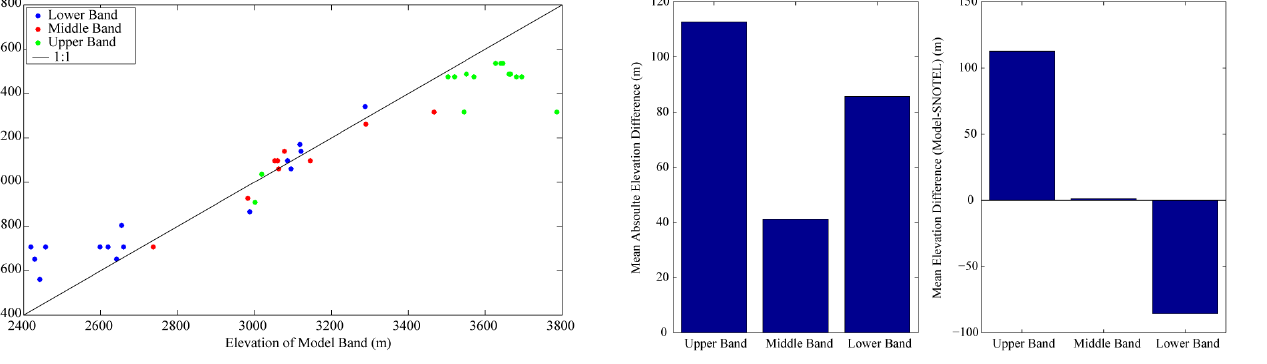
Fig. 3. Mean absolute difference (left) and mean difference (right) between model elevation and its respective SNOTEL elevation. A positive mean difference indicates the model is at a higher elevation than its SNOTEL